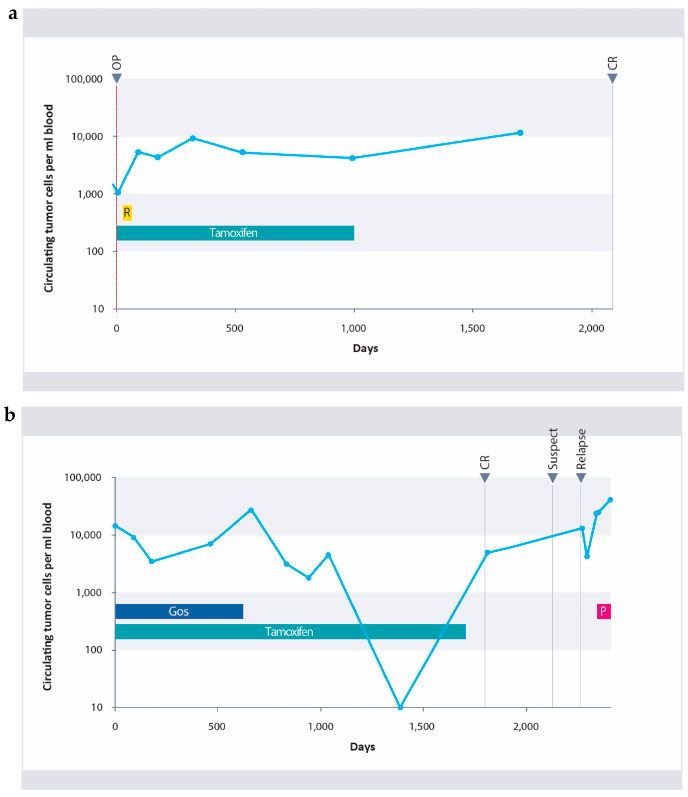
Figure 4. ( a ) Course of CETCs in a patient with invasive ductal carcinoma (pT1bpN2aM0). Initially, an increase in cell numbers under radiotherapy was observed (hatched in yellow). Cell numbers remained primarily constant under further Tamoxifen therapy (blue). Follow-up samples of the patient revealed macroscopic complete remission (CR). ( b ) Course of CETCs in a patient with invasive lobular carcinoma who was treated with neoadjuvant therapy (ypT1a(m)pN1aM0). Under combined therapy comprising of Goserelin (hatched in dark blue) and Tamoxifen (blue), an initial decrease in CETCs was observed, followed by a renewed increase during further combination therapy. Under monotherapy with Tamoxifen a continuous decrease in CETCs was observed followed by a renewed increase of CETCs after completion of endocrine therapy. At that time the patient was macroscopically still in complete remission. After additional 10 months recurrence was confirmed and after mastectomy was treated with Paclitaxel